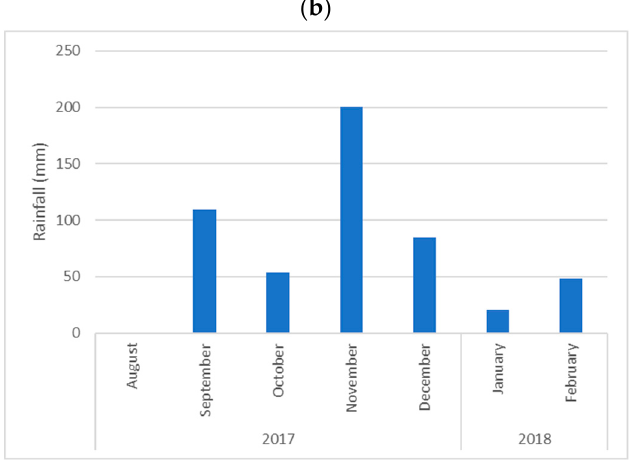
Figure 2. ( a ) Rainfall data of 1-year test: 264.2 mm of rain from August 2016 to December 2016; 213.8 mm from January 2017 to February 2017. ( b ) Rainfall data of 2-year test: 448 mm of rain from August 2017 to December 2017; 69 mm from January 2018 to February 2018.